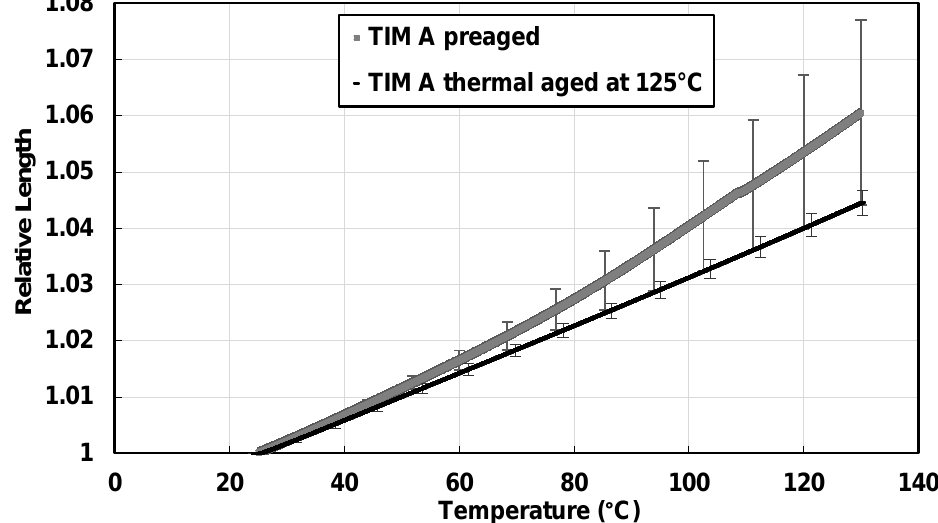
Figure 11. Change in relative length with temperature of TIM A.